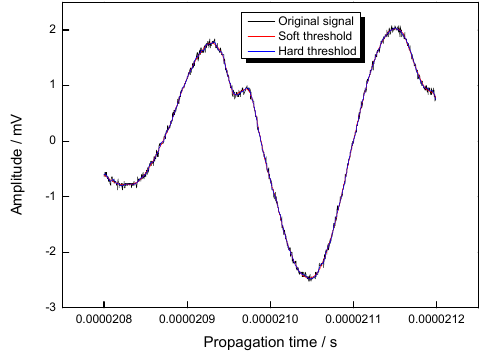
Figure 6. L cr wave after denoising.